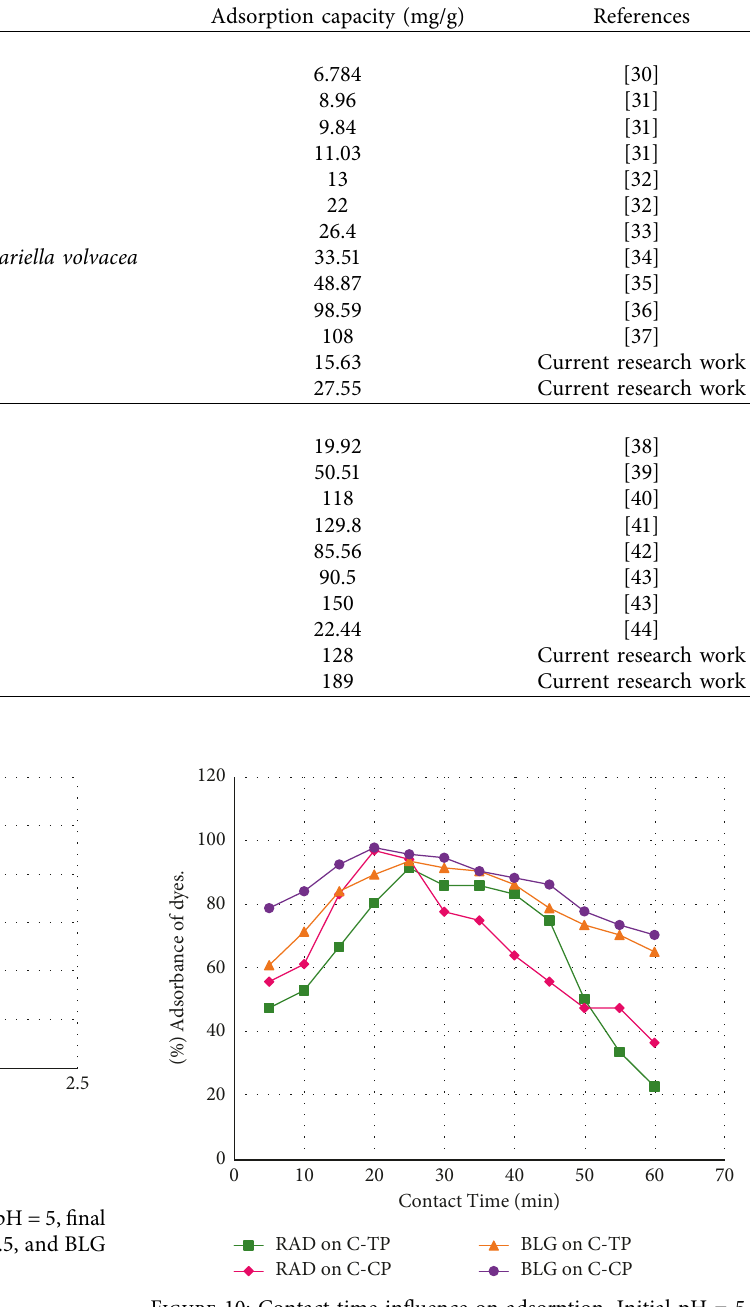
Table 2: A comparison of the adsorption capacity with some previously published works.